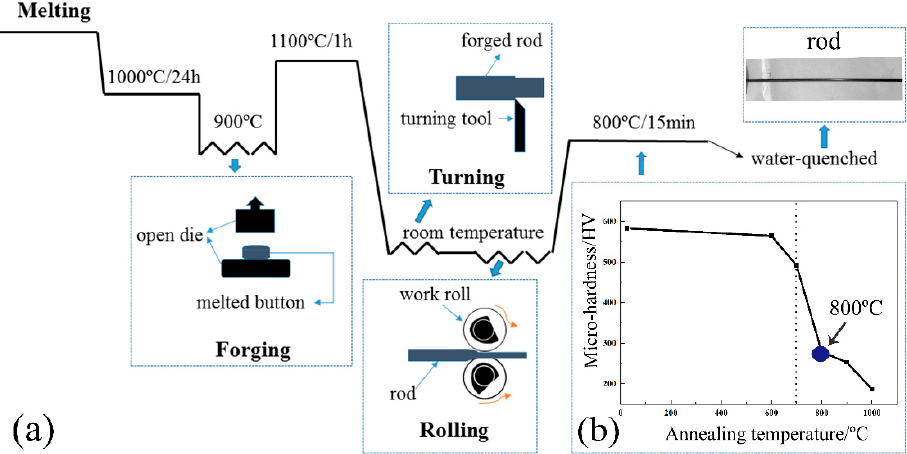
Figure 1. ( a ) Schematics of thermos-mechanical processing of specimens: forging, turning and roll- ( b ) Micro-hardness of specimens at different annealing ing; ( b ) Micro-hardness of specimens at different annealing temperatures.